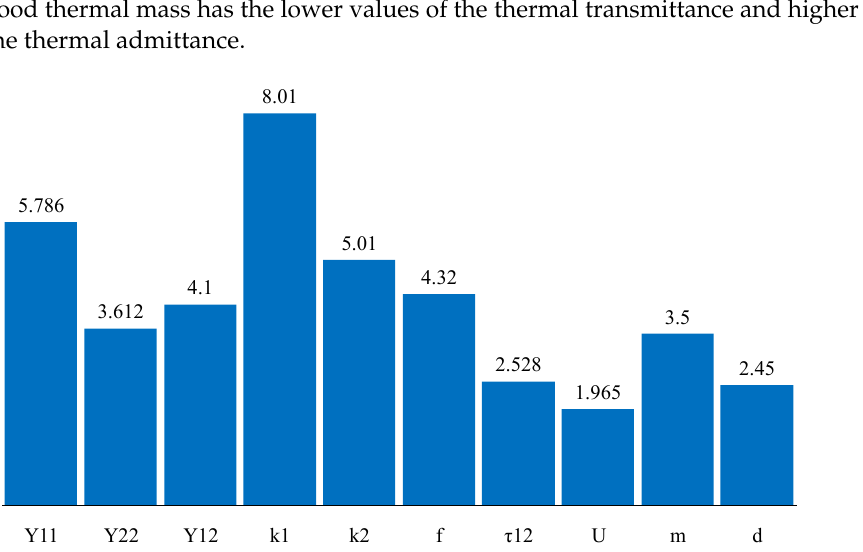
Figure 4. Dynamic characteristics of the external wall of the ventilated façade with the minimum layer thickness.